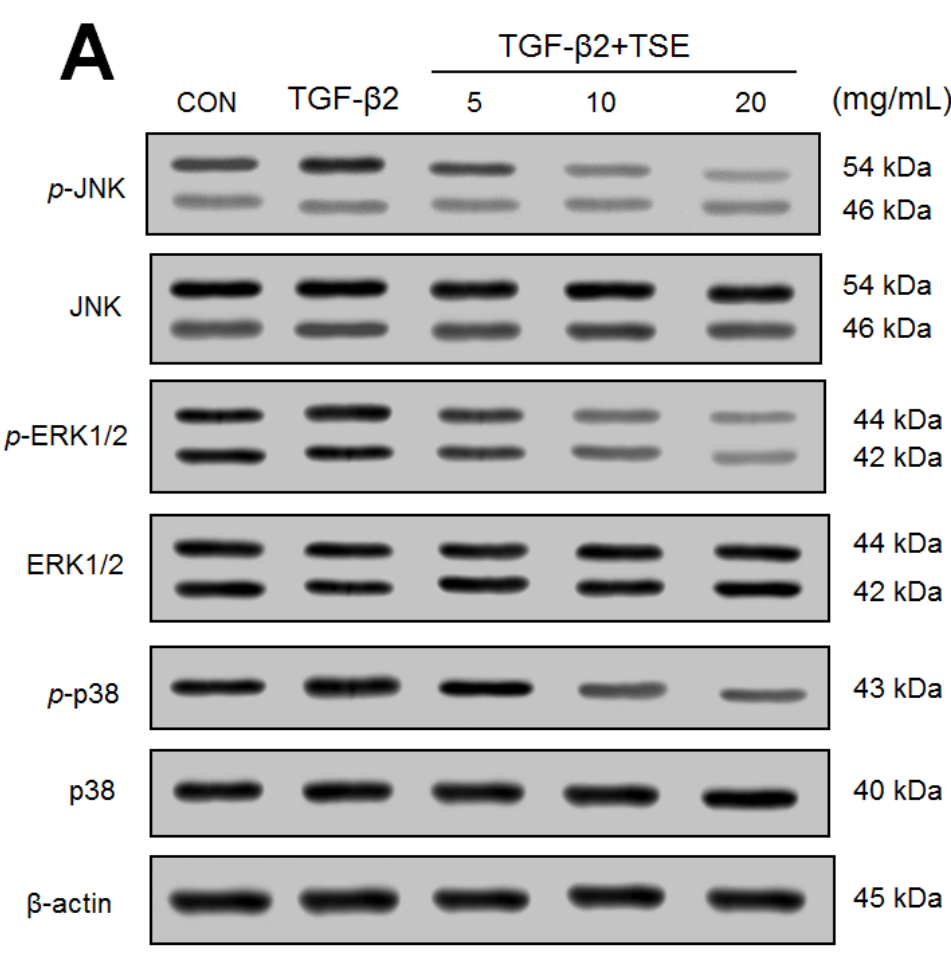
3.7. Effects of TSE on the Protein Expression of p- JUN/JUN, p-ERK1/2/ERK1/2, p-p38/p38, p-Akt (Ser 473 )/t-Akt, and p-Akt (Thr 308 )/t-Akt in SRA01/04